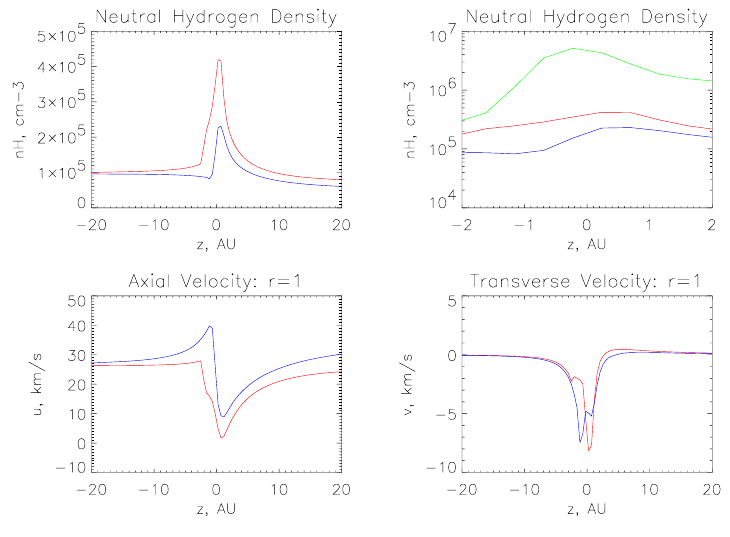
Fig. 4. Number densities, axial and ra- dial components of velocity of the neu- tral gas-loaded flow versus axial dis- tanse z , at a radial coordinate r = 1 are shown by red curves. Here n i = 10 5 cm − 3 , V i = 26km/s, T i = 100K, β 0 = β φ = 8 · 10 − 8 s − 1 , ω = 1 at 1AU and R min = 1AU, respectively. For comparison, results for the case with- out gas-loading also are shown by blue curves. At the top right panel different cases, without gas-loading, with gas- loading at ω = 1 and gas-loading at ω = 10 are shown by blue, red and green curves, respectively. Everywhere µ = 0 .